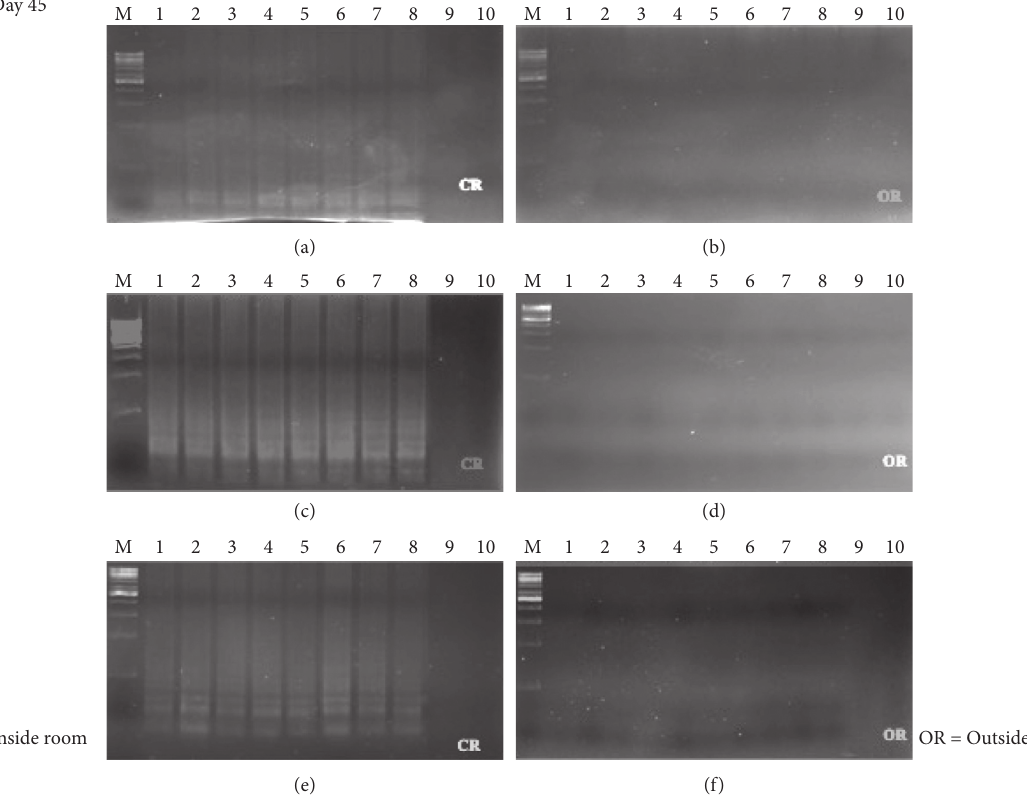
Figure 2: Time course detection of DNA sample stained on different surfaces in day 45. (a), (b) brick, (c), (d) cloth, and (e), (f) tile. M � 1kB DNA ladder, lane 1–9 � male sample 1–8, and lane 9, 10 � female sample